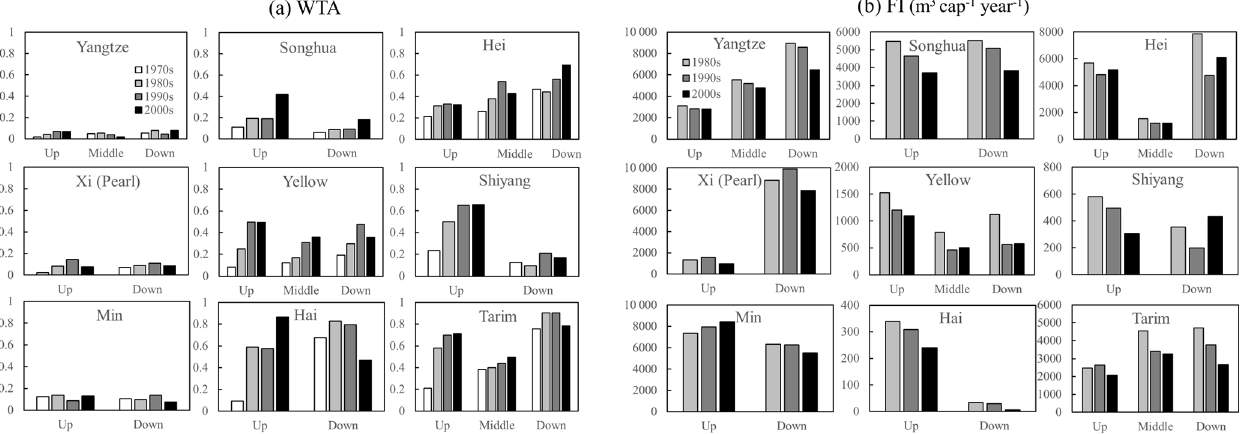
Figure 5. Trajectories of WTA and FI in upstream, middle stream, and downstream regions for nine large basins from the 1970s and 1980s to the